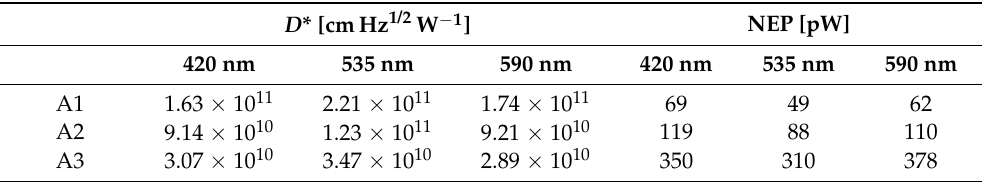
Table 7. Detectivity ( D *) and noise equivalent power (NEP) of the Au/SRO/Si structures at different